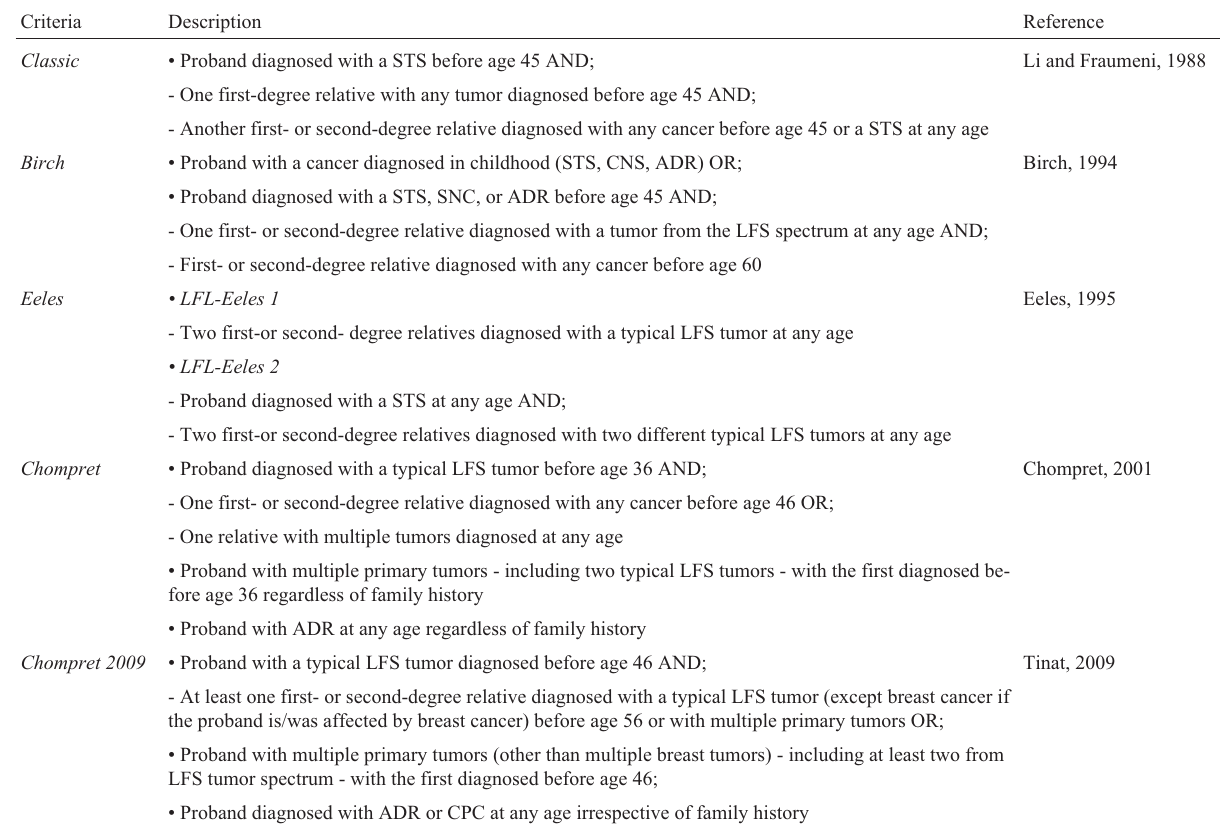
Table 1 - Clinical criteria for LFS diagnosis Criteria